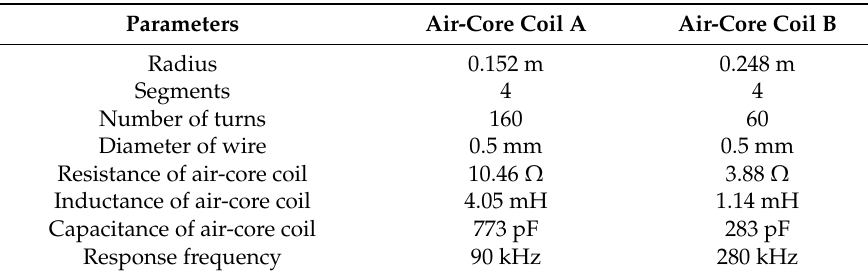
Table 1. Parameters of the two air-core coils.